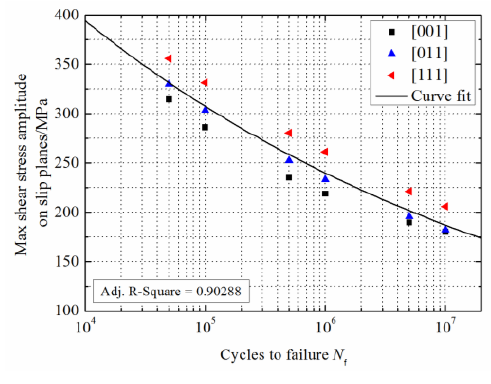
◦ C using the proposed model.